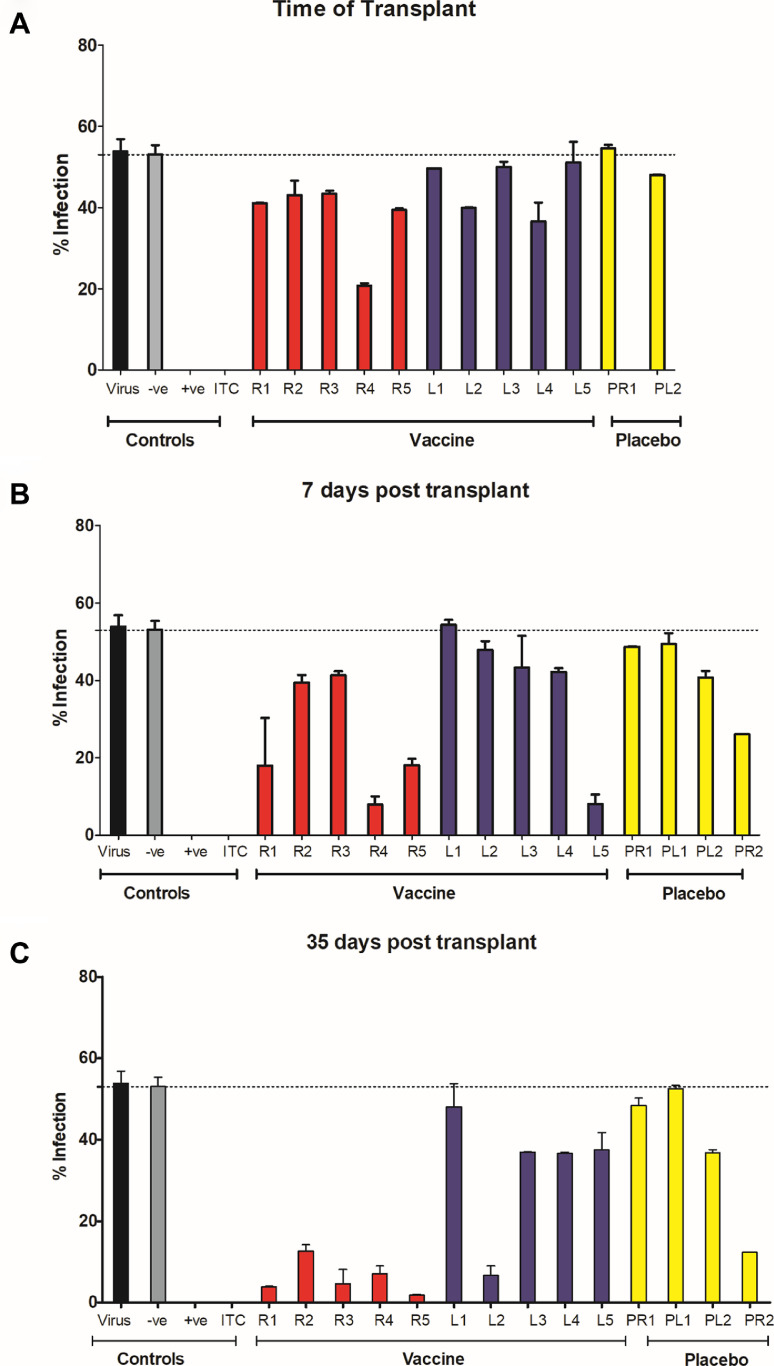
Neutralizing antibody responses in post-transplant serum samples from vaccinated individuals appear faster than in placebo recipients.HCMV (Merlin strain) was incubated with neutralizing antibody ITC88 (ITC) or sera (1:10) from seronegative patients from the phase II trial. For controls, pooled serum from healthy seropositive (+ve) or seronegative (-ve) donors were used (n = 10). Following incubation, the antibody:virus mixes were used to inoculate HFFs in vitro (MOI=1). Infection was measured by IE staining and the proportion of infected cells calculated by counterstaining nuclei with DAPI. Sera was analysed from vaccine recipients receiving a kidney (R1-R5; red) or liver (L1-L5; blue), or placebo recipients (yellow) receiving a kidney (PR1 & 2) or liver (LR1 & 2). The average percentage infection following incubation with post-transplant serum is shown for each individual A) at the day of transplantation B) 7 days post transplantation, C) 35 days post transplantation, D) 63 days post transplantation and E) 90 days post transplantation. (For interpretation of the references to color in this figure legend, the reader is referred to the web version of this article.)